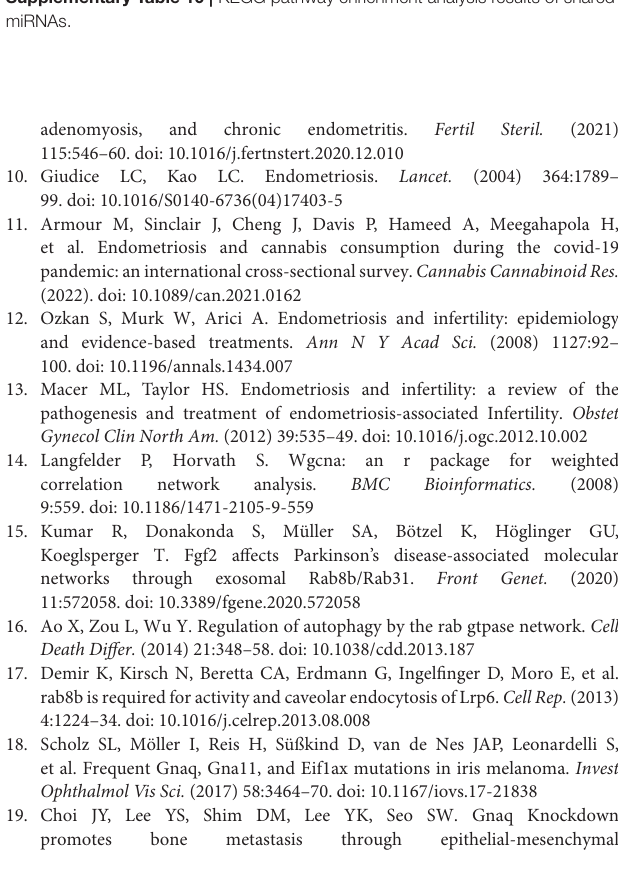
Supplementary Table 1 | Four gene modules associated with EMs. Supplementary Table 2 | Four gene modules associated with RPL. Supplementary Table 3 | Shared genes for EMs and RPL. Supplementary Table 4 | PPI network analysis results of shared genes. Supplementary Table 5 | GO term enrichment analysis results of shared genes. Supplementary Table 6 | KEGG pathway enrichment analysis results of shared genes. Supplementary Table 7 | MiRNAs associated with EMs and RPL. Supplementary Table 8 | Target genes corresponding to shared miRNAs. Supplementary Table 9 | MiRNAs-mRNAs regulatory network. Supplementary Table 10 | KEGG pathway enrichment analysis results of shared